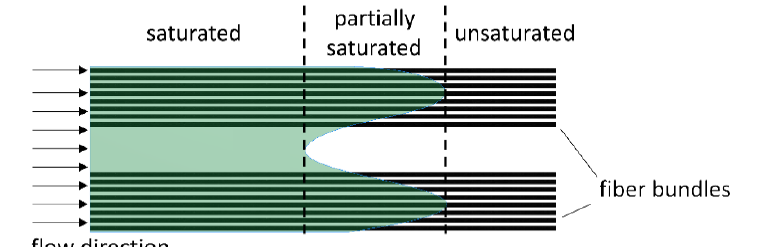
Figure 1. Saturated, partially saturated, and unsaturated regions of the flow front in a unidirectional preform.